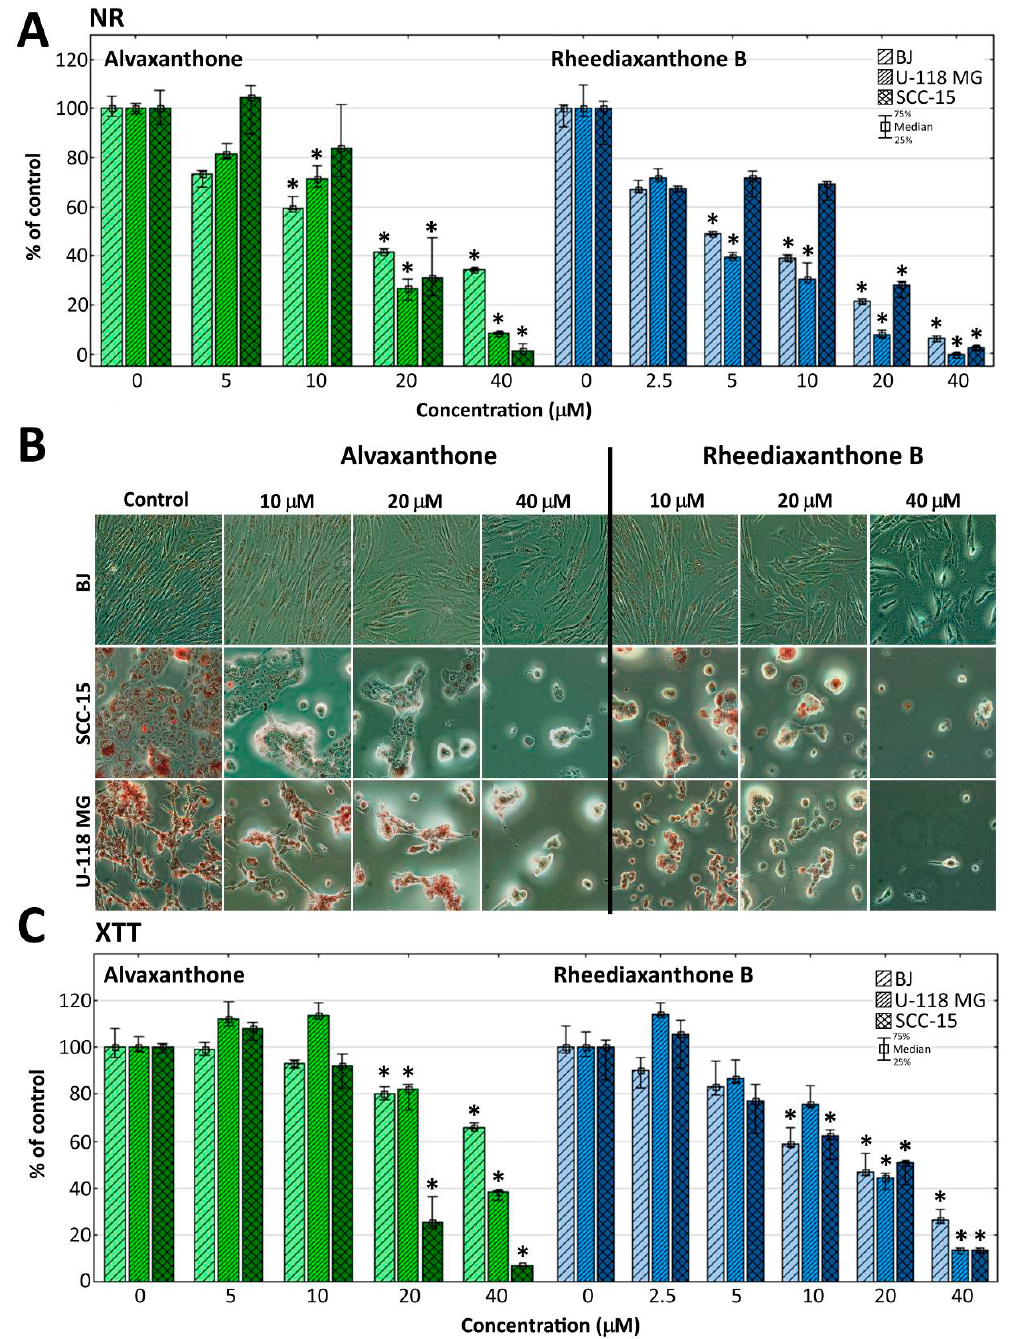
Figure 1. Viability of BJ, U-118 MG and SCC-15 cells after 48 h treatment with alvaxanthone or rheediaxanthone B, estimated by NR ( A ) and XTT ( C ) assays. Each bar represents the median of a population of 9 results, obtained in consequence of three independent experiments, each done in triplicate. The whiskers are the lower (25%) and upper (75%) quartile ranges. The results significantly different from control (in a view of the Kruskal–Wallis test) are marked * ( p ≤ 0.05). ( B ) Cell morphology and neutral red accumulation following 48 h alvaxanthone or rheediaxanthone B treatment and 1 h incubation with neutral red. Red vesicles are lysosomes containing the dye. 2.6. Proliferation